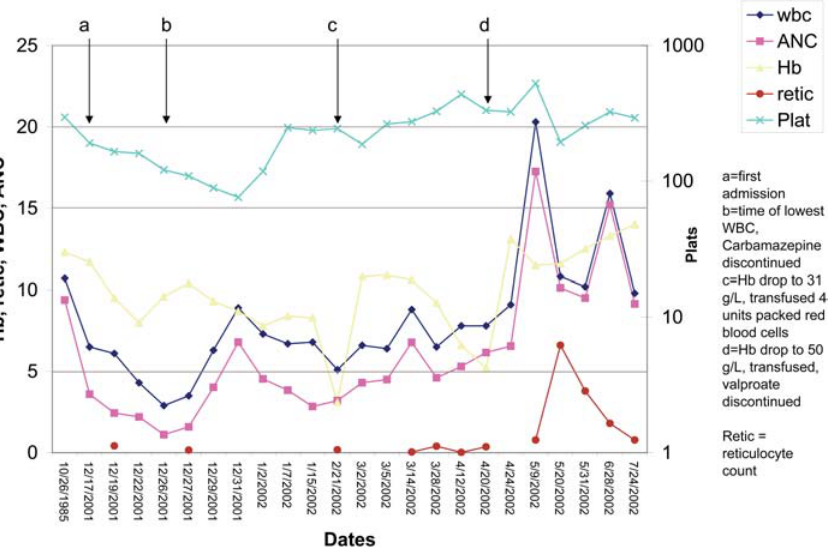
Figure 1. Patient’s Clinical Course, Complete Blood Count, and Reticulocyte Count The x-axis shows specific dates. In 1985, prior to starting anticonvulsants, the only abnormality was an MCV of 106 fl. On admission (a), in 2001, the only abnormality was an increased MCV of 119 fl. During the second week of admission (b), her WBC, then her platelet count, dropped to their lowest levels, while her Hb showed a gradual decline. Bone marrow biopsy showed suppression of all marrow elements. After stopping carbamazepine, there was a brisk recovery of her WBC and platelet counts. Six weeks later (c), in February 2002, her Hb had dropped to 31 g/l, and she was given a transfusion of packed cells. Eight weeks later (d), in April 2002, despite erythropoietin and steroid therapy, her Hb dropped to 53 g/l and she received another transfusion. At this time, the sodium valproate was stopped. The reticulocyte count had remained abnormally low throughout this period (a–d), and it was only after stopping the valproate that the reticulocyte count and Hb started to rise. Her MCV dropped after the first transfusion and did not rise again until there was a brisk reticulocyte response. ANC, absolute neutrophil count; retic, reticulocytes; Plat(s), platelets. DOI: 10.1371/journal.pmed.0010051.g001